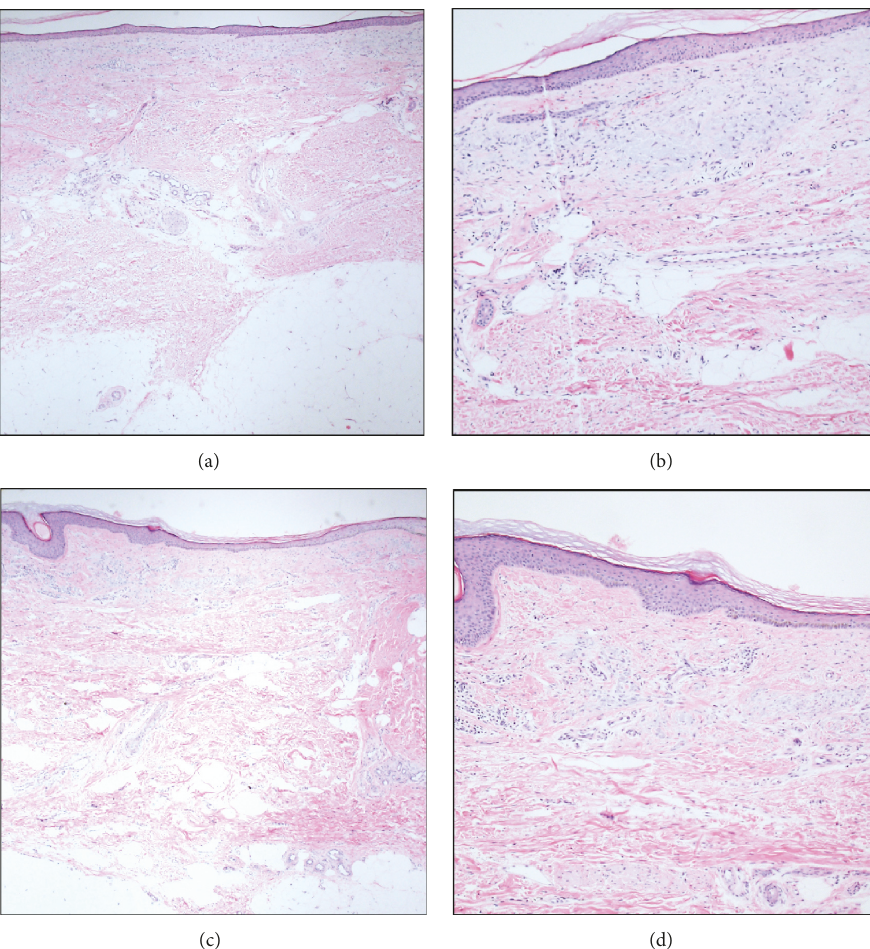
Figure 1: Skin punch biopsies before ((a) at 4x magnification; (b) at 10x magnification) and after ECP ((c) at 4x magnification; (d) at 10x magnification). Despite clinical improvement, interval changes in histology were not dramatic. Fibrocollagenous thickening of dermis was seen in both biopsies. In addition, dermal perivascular plasmacytic infiltrates were minimal in both